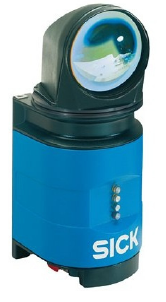
Figure 5. Sick LD LRS10001